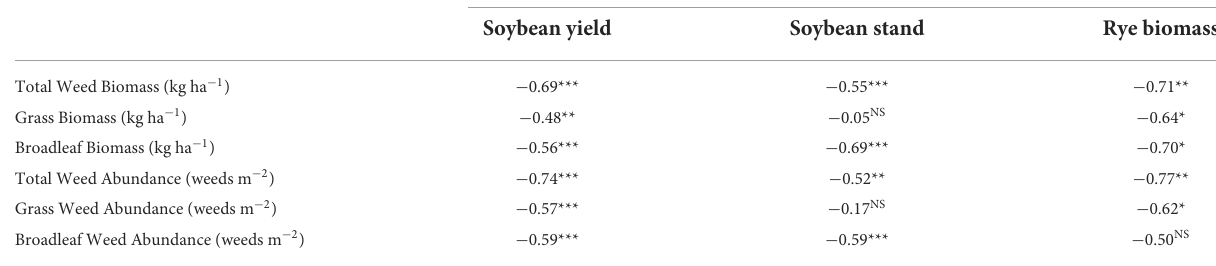
TABLE 4 Pearson correlation coefficients ( r values) between the soybean grain yield (Mg ha − 1 ), the soybean stand (plants ha − 1 ), and the rye biomass (kg ha − 1 ) with measures of weed parameters located at the Arlington Agricultural Research Station in Arlington, WI and the Michael